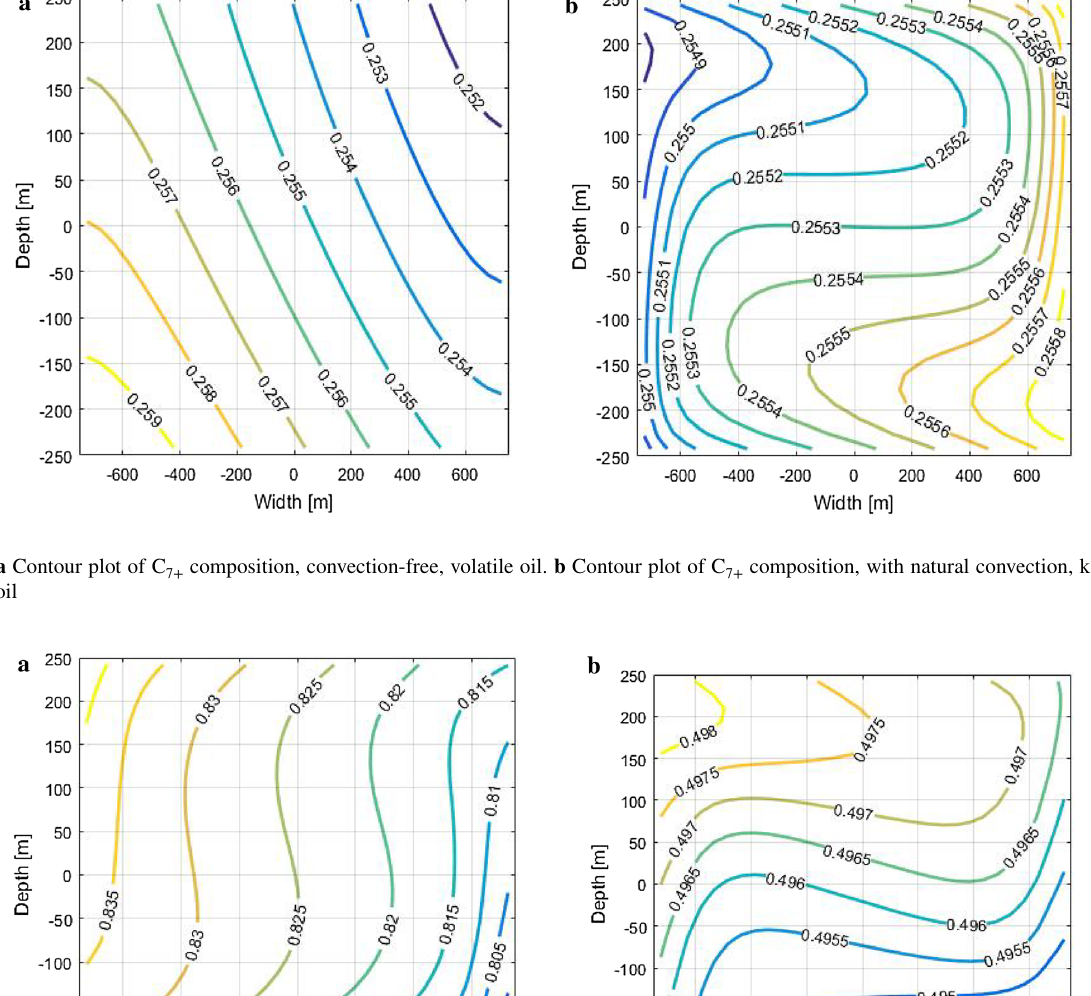
k = 1 md, gas condensate. b Contour plot of C